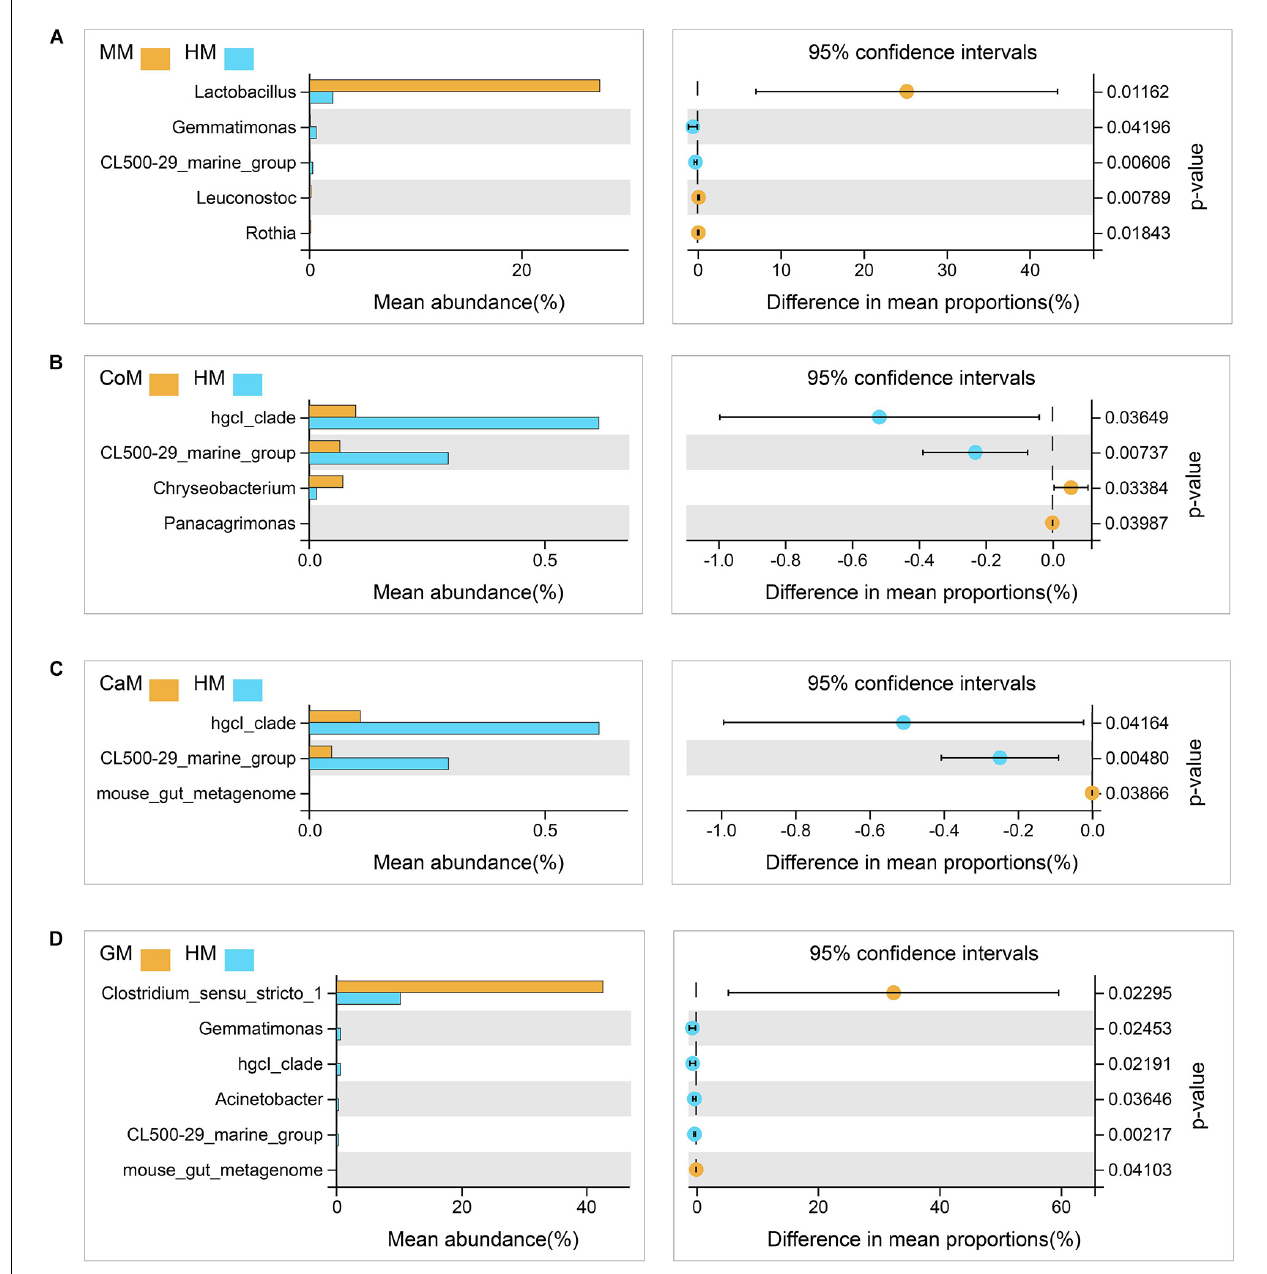
FIGURE 5 | Taxa changed after fermentation. (A) Mare milk versus Human milk; (B) Cow milk versus Human milk; (C) Camel milk versus Human milk; (D) Goat milk versus Human milk. 95% confidence intervals, p <